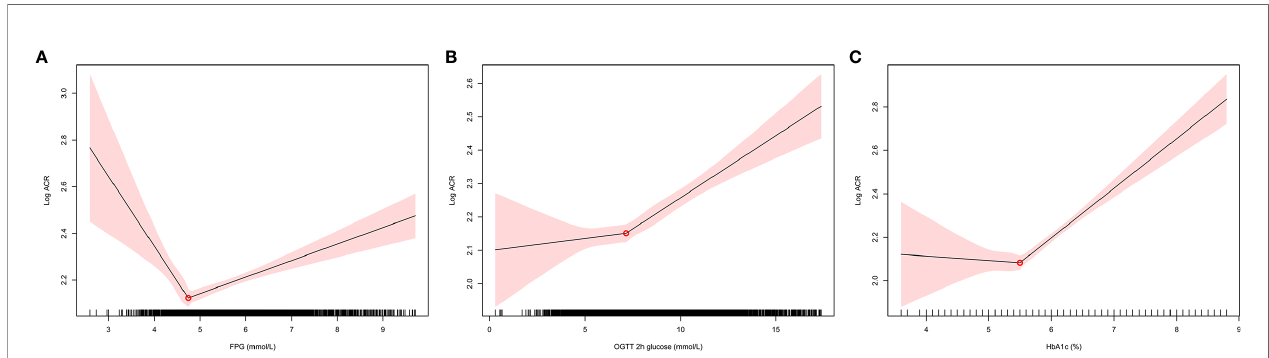
FIGURE 1 | The relationships between blood glucose and log-ACR were examined using 2-slope linear regression models. The in fl ection points of log-ACR with (A) : FPG, (B) : OGTT 2h glucose, (C) : HbA1c. FPG, fasting plasma glucose; OGTT, oral glucose tolerance test; ACR, albumin:creatinine